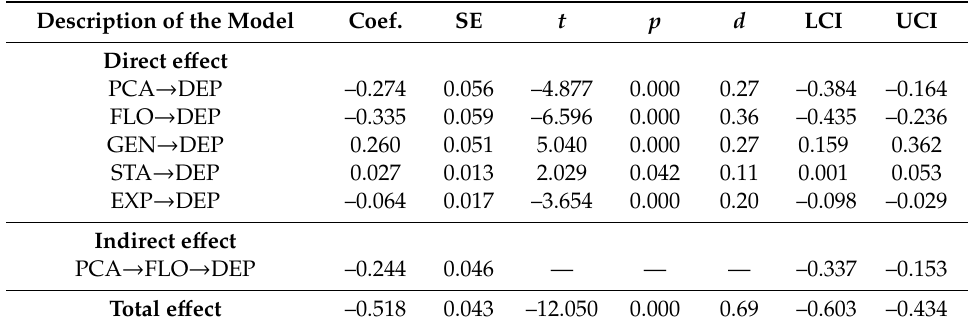
Table 3. Results of the mediation analysis of flourishing in the relationship between PsyCap and